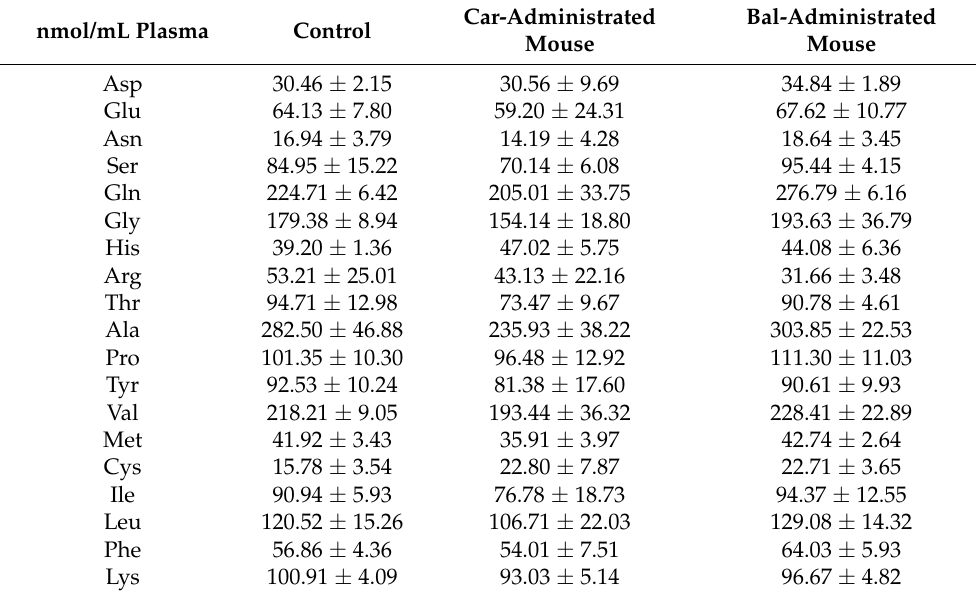
Table 1. Amino acid concentrations in mouse plasma after 1 h from administration of water (control) carnosine (Car) and opah-derived balenine